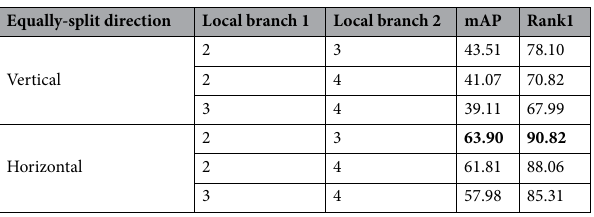
Table 2. The results of different feature map segmentation setup. Bold indicate the best results for the corresponding metrics.